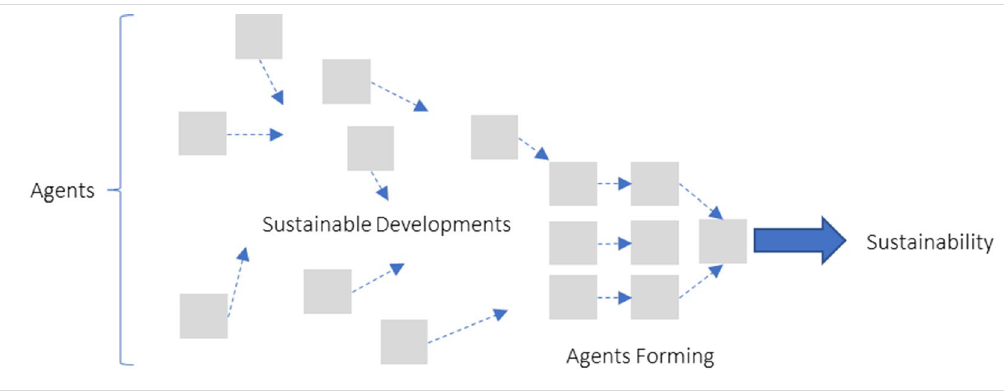
Fig. 7 ABM and Sustainability Transitions